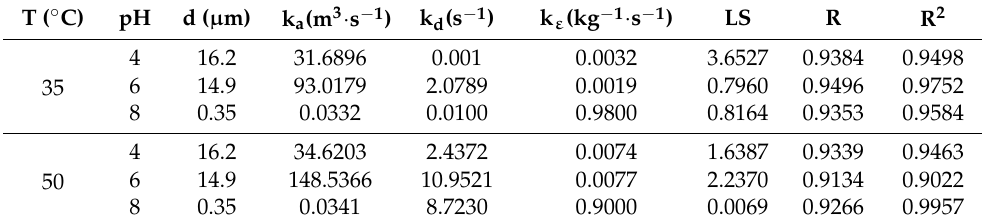
Table 1. Identified values of the model